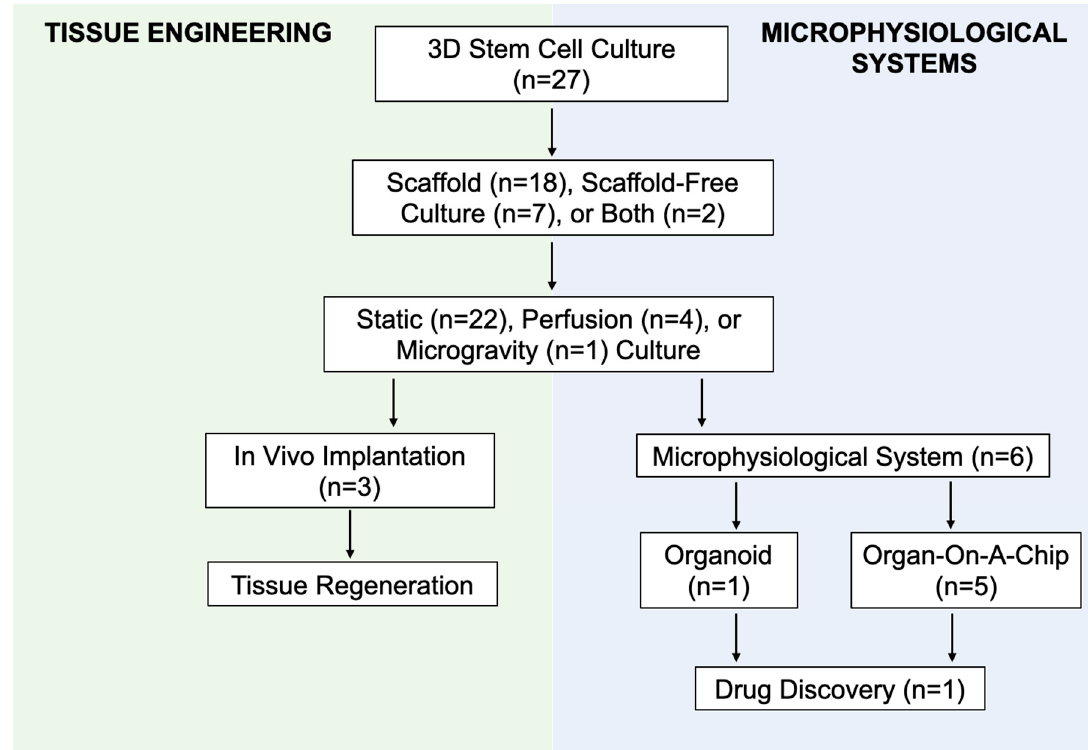
Figure 6. Flow diagram demonstrating the intersection between culture methods for adipose tissue engineering and microphysiological systems (MPS).